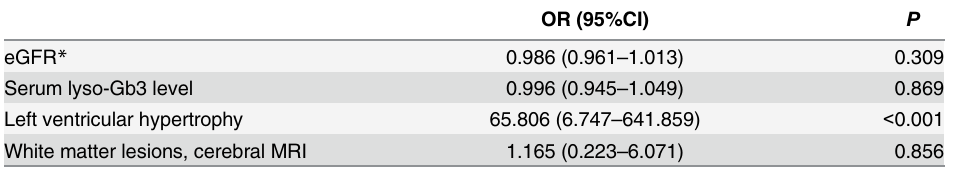
Table 2. Multiple logistic regression analysis for elevated cardiac troponin (cut-off (cid:1) 0.04 ng/ml) patients with Fabry disease (n =